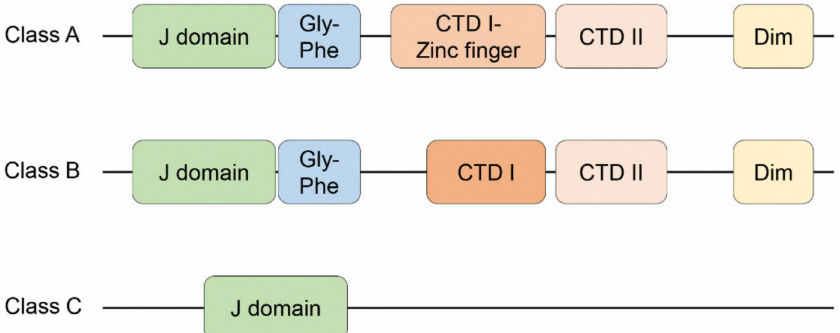
Figure 1. Structures of three types of HSP40/JDPs. Class A and B have the N-terminal J-domain, a Gly-Phe rich region (Gly-Phe), two C-terminal β -barrel domains (CTD I and CTD II), and a dimerization domain (Dim). A zinc-finger domain in the CTD I (CTD I-Zinc finger) is specific to the class A. Not all class B HSP40/JDPs contain CTD II and dimerization domains. J-domain containing proteins that do not fit to the criteria of class A or class B are classified as class